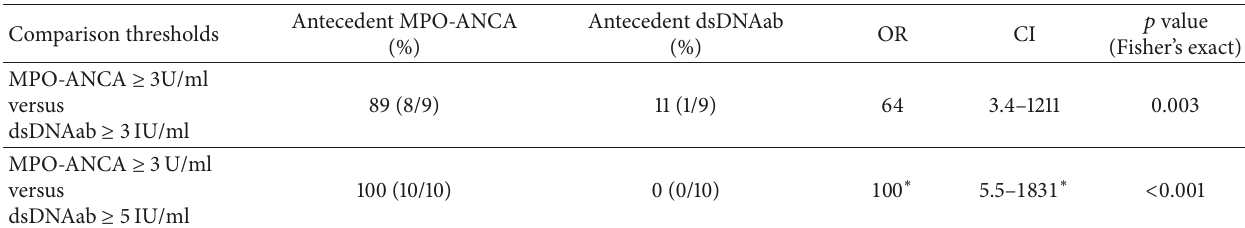
Table 5: Temporal relationship of detectable autoantibodies. Patients without a clear antecedent antibody above the designated threshold were not included in analysis. OR, odds ratio; CI, confidence